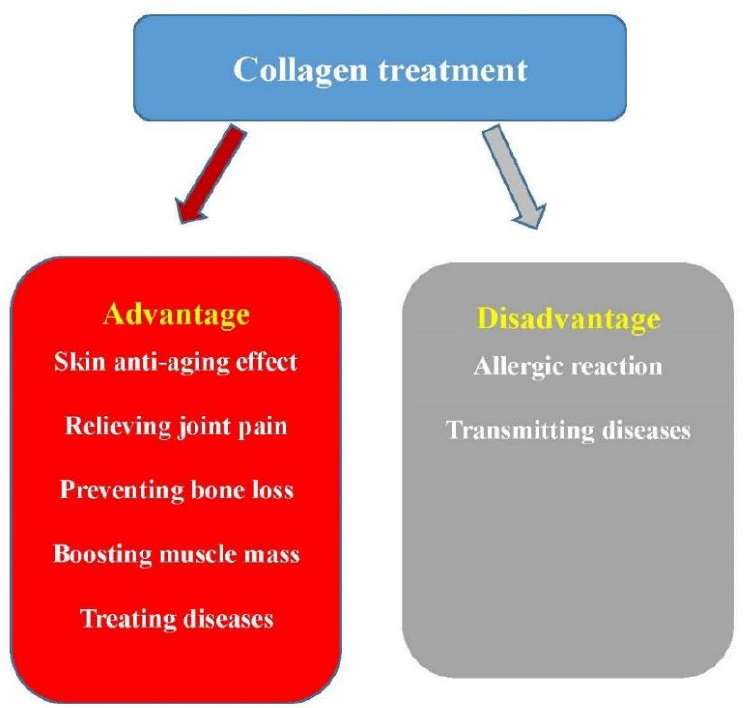
Figure 4. Some advantages and disadvantages of the collagen treatment.